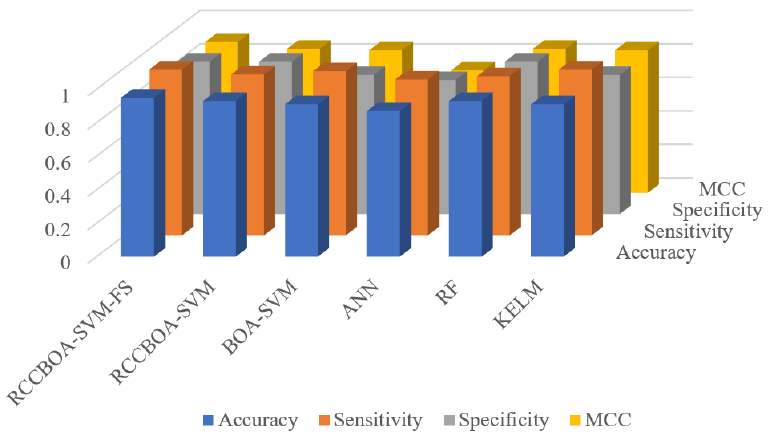
Figure 6. Classification results obtained by the five models in terms of four metrics.